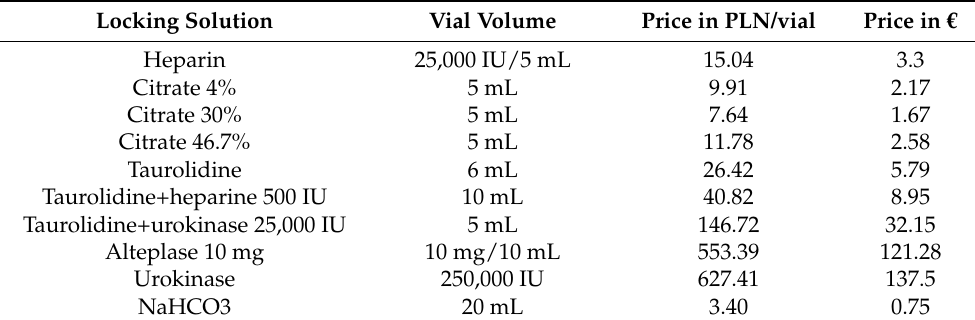
Figure 2. Summary of the properties of locking solutions. On the left, solutions with anticoagulant properties. On the right, locks with antimicrobial properties. In the middle, solutions with both of these properties. Table 2. Summary of the estimated cost of locking solutions.